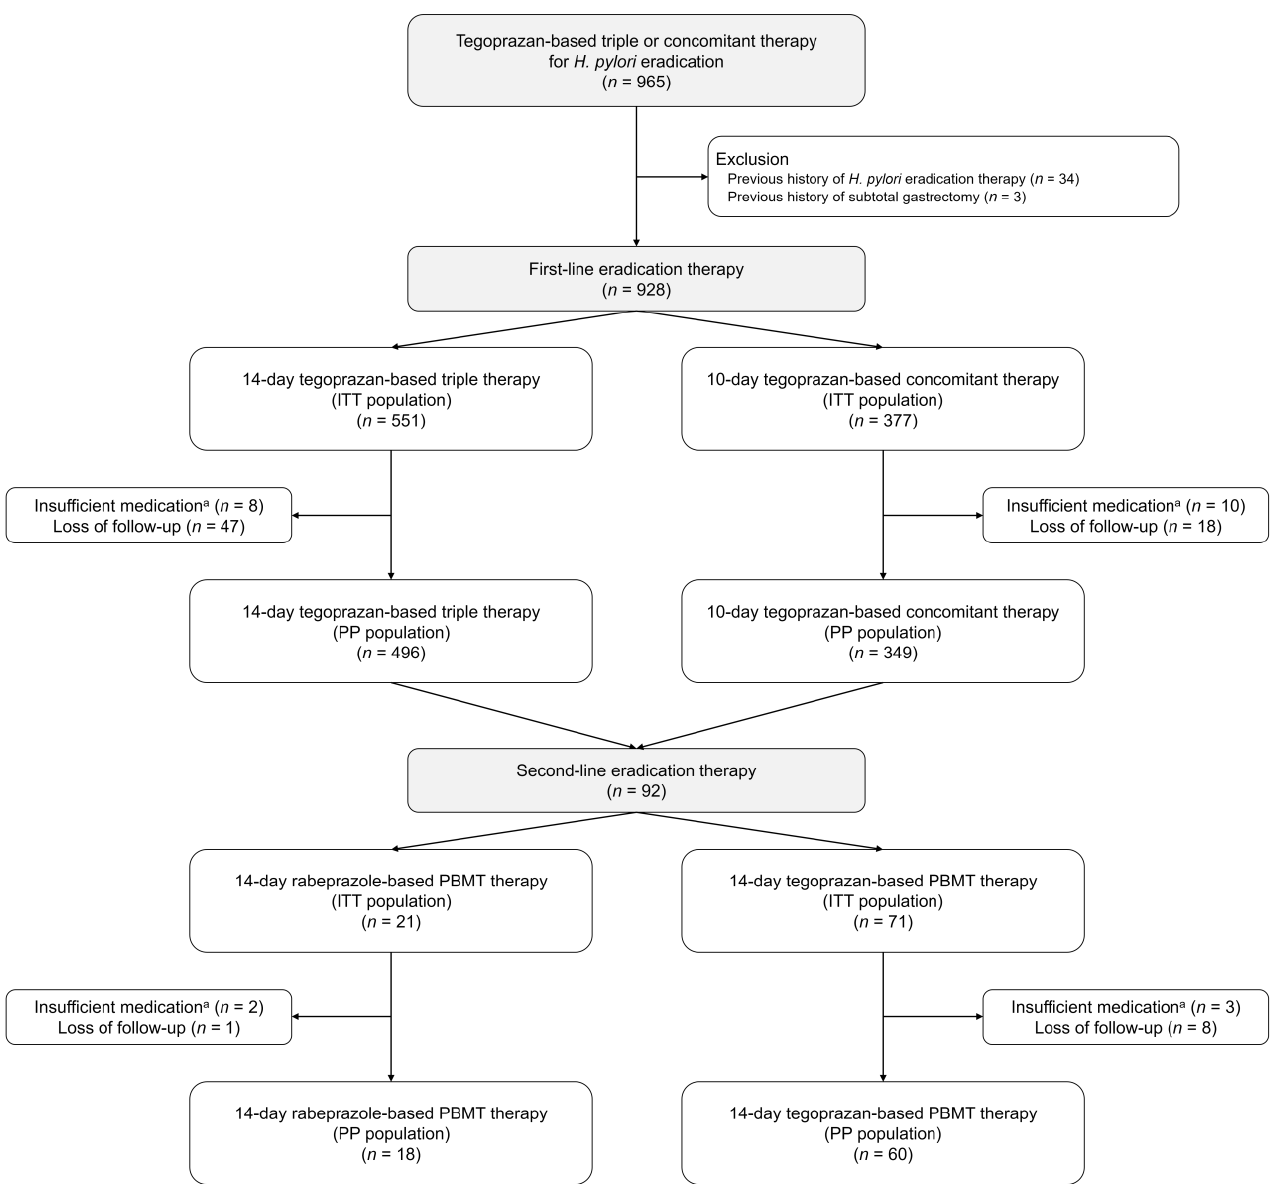
Figure 1. Study flow diagram. a Insufficient medication is determined as administration of <80% of prescribed medication. PBMT indicates bismuth-containing quadruple therapy comprising a proton pump inhibitor (PPI; or potassium-competitive acid blocker [P-CAB]), bismuth, metronidazole, and tetracycline. ITT, intention-to-treat; PP, per-protocol; PPI, proton pump inhibitor; P-CAB, potas- sium-competitive acid blocker.